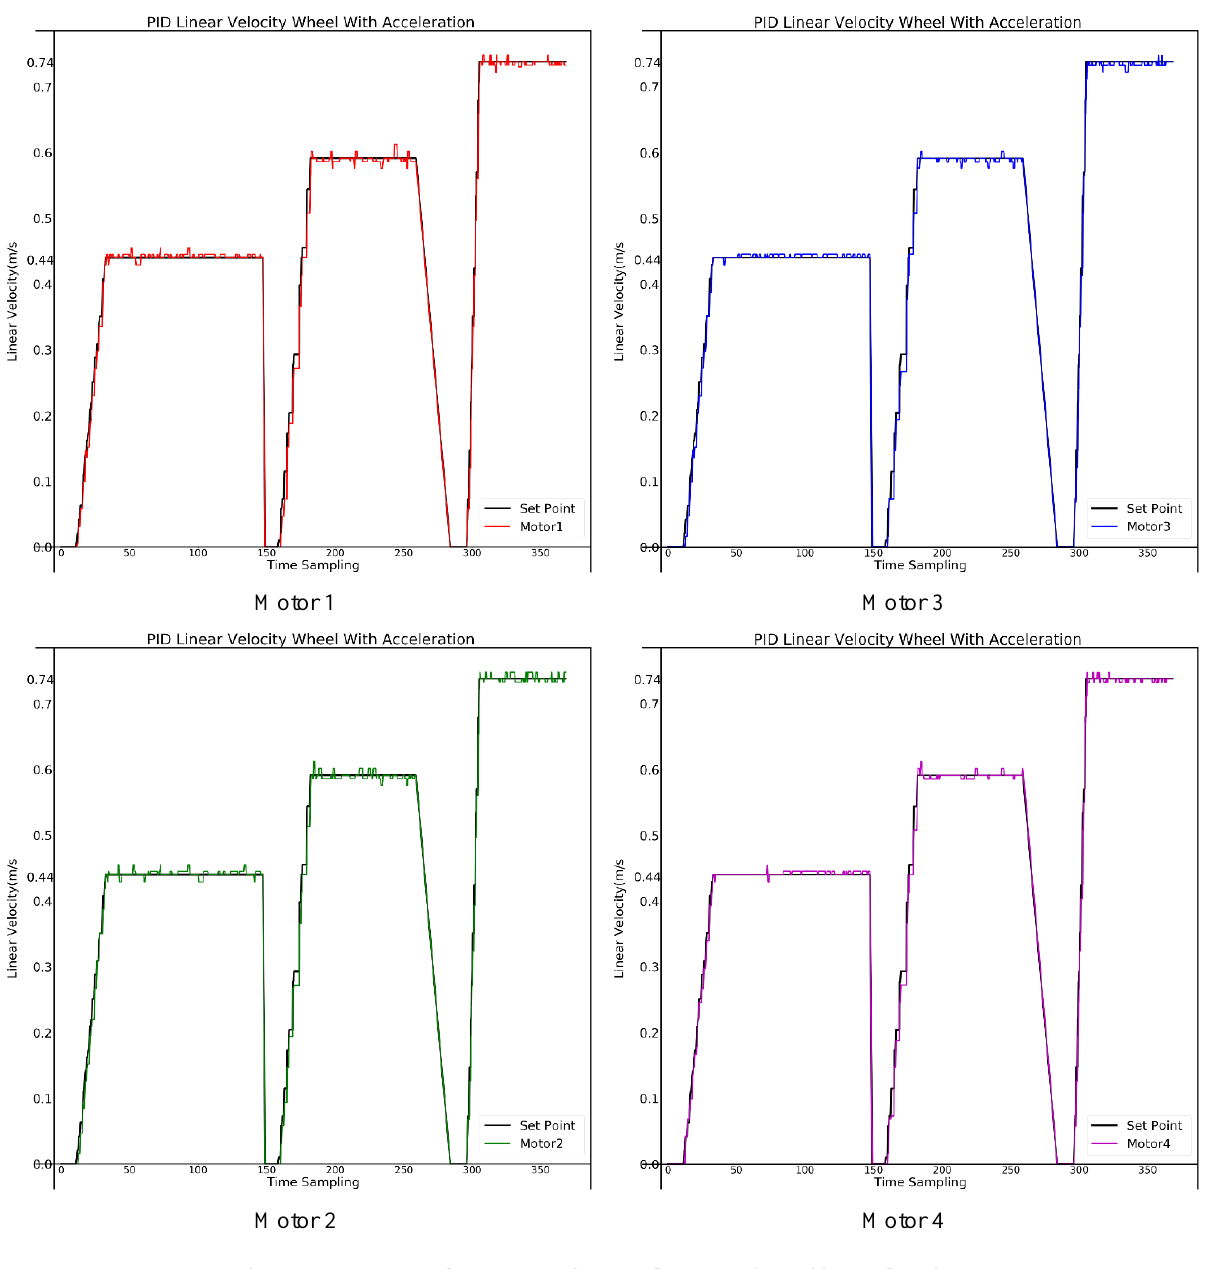
Figure 12. Response of Motor Speed Control to Set-points with Acceleration. Table 4. Parameters of PID Motion Tuning